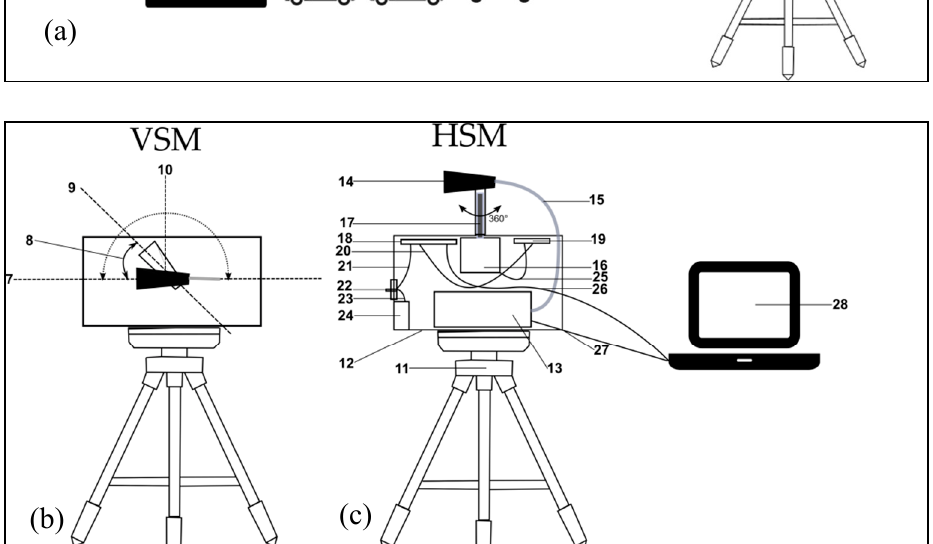
Figure 2. The UGAL-2-DOAS system. ( a ) Measurement principle: (1) radiation source; (2) radiation rays; (3) pollution plumes; (4) pollution sources; (5) field of view (FOV) of the device; (6) multi-axis di ff erential optical absorption spectroscopy (MAX-DOAS) system. ( b ) Components and main characteristics of the scanning mode: (7). horizontal axis, (8) viewing angle (9) observat ion direction, (10), zenith; ( c ) Components: (11) tripod, (12) body, (13) ultraviolet–visible (UV–Vis) spectrometer; (14) telescope; (15) optic fiber; (17) mobile arm; (16) motor; (18) board; (19) electronic driver board; (20–23) electric connectors; (24) power switch; (25) accumulator; (26–27) communication cables; (28) storage unit.